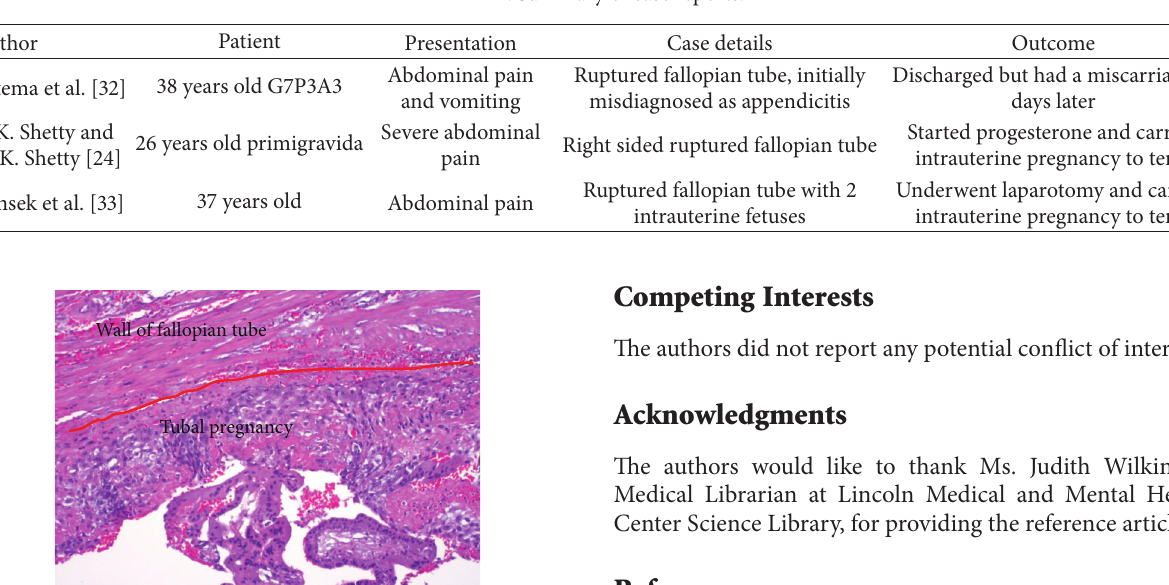
Table 1: Summary of case reports.